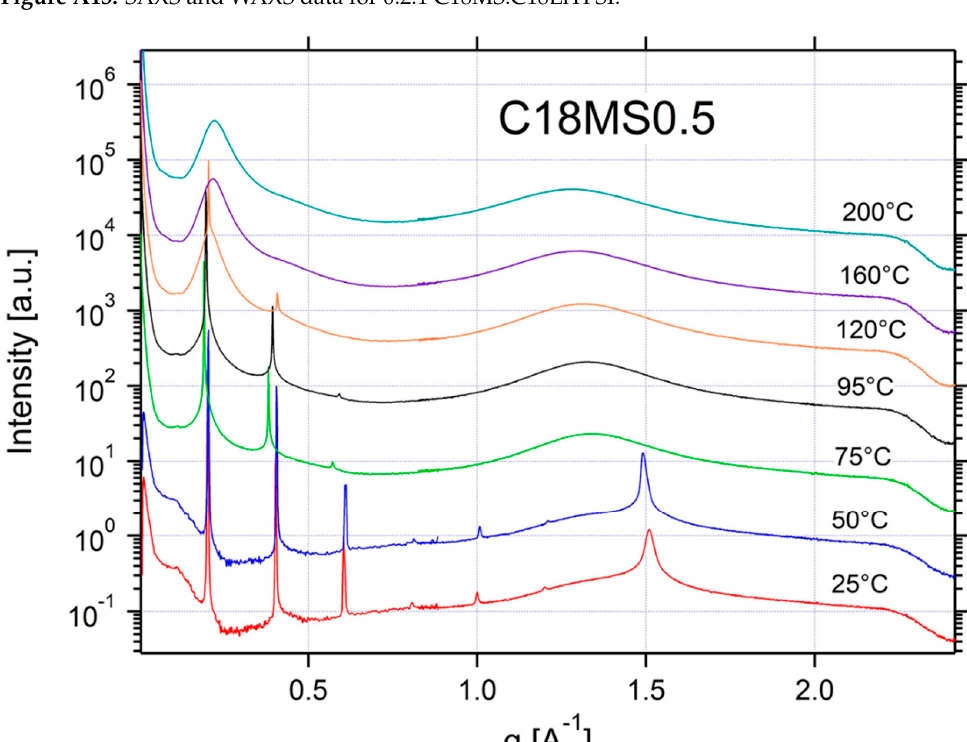
Figure A14. SAXS and WAXS data for 0.5:1 C18MS:C18LiTFSI.